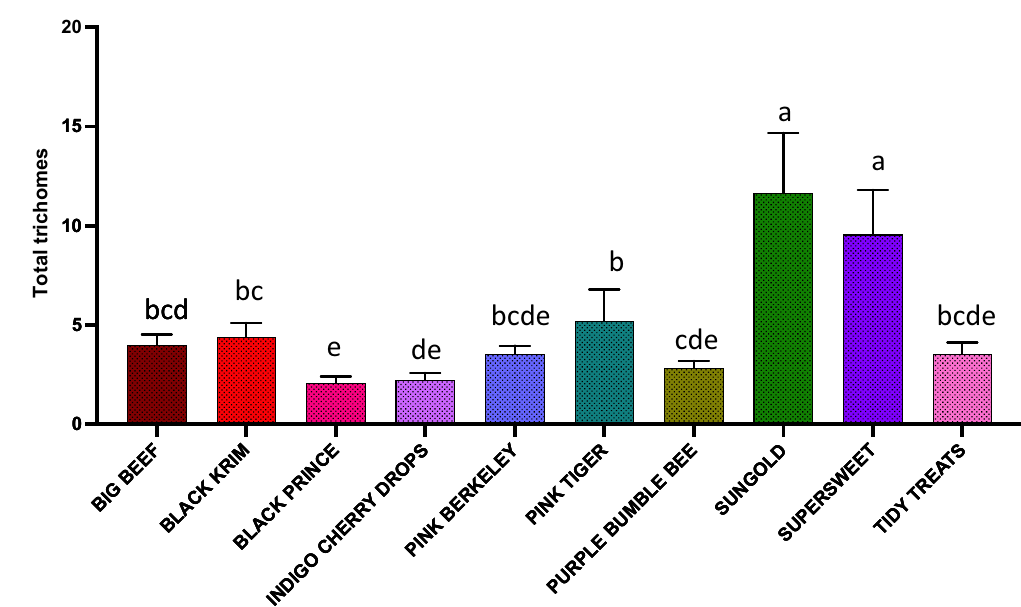
Fig. 3 The comparison of total number of trichomes present in ten varieties of tomato. Detailed statistics are presented in Table